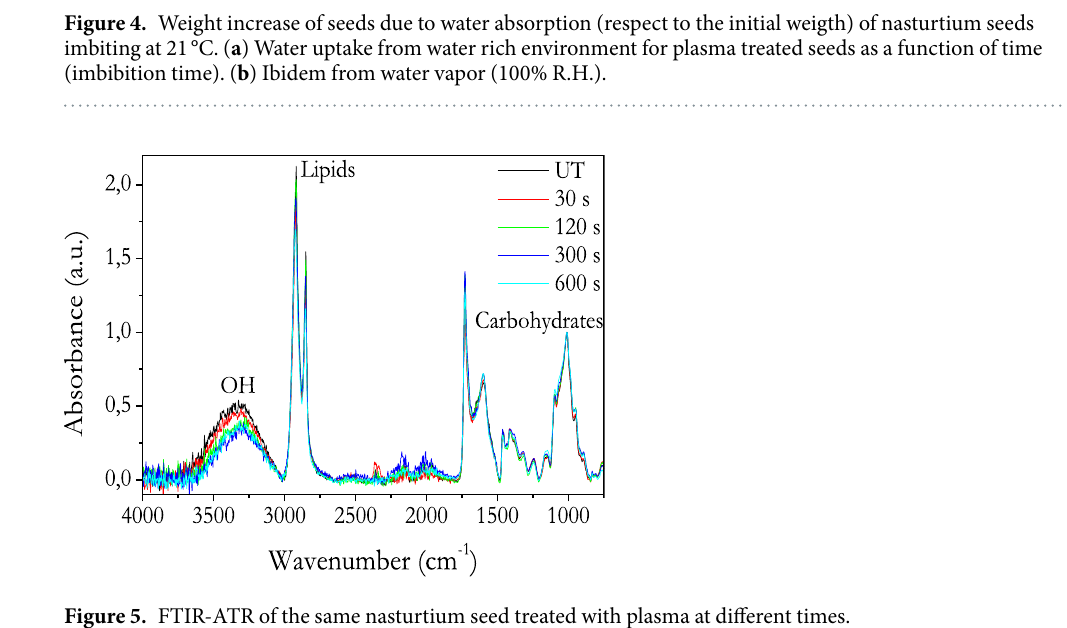
Figure 5. FTIR-ATR of the same nasturtium seed treated with plasma at different